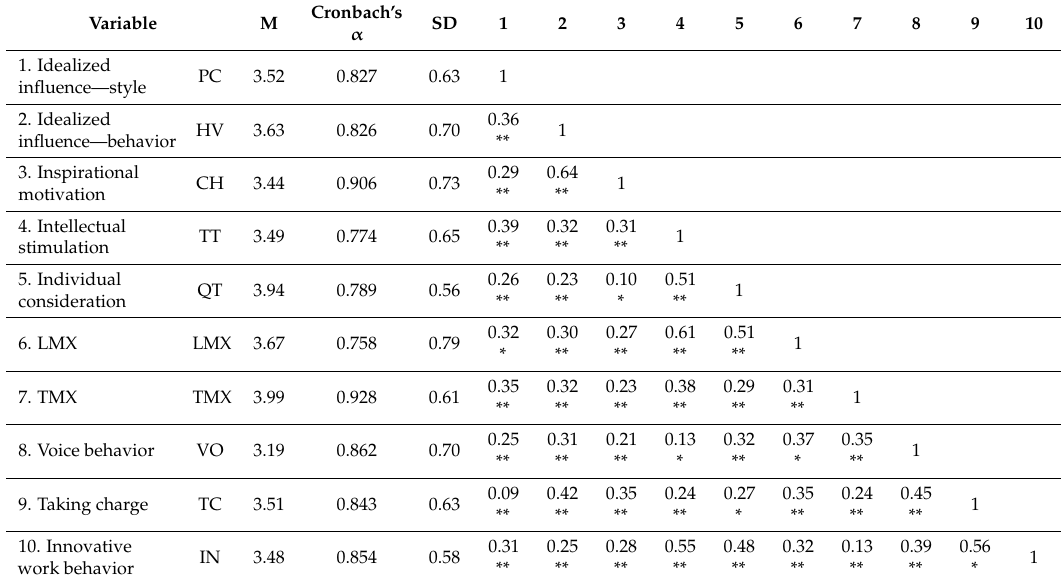
Table 1. Mean (M), Cronbach’s α testing result, standard deviations (SD), and intercorrelations of study variables.